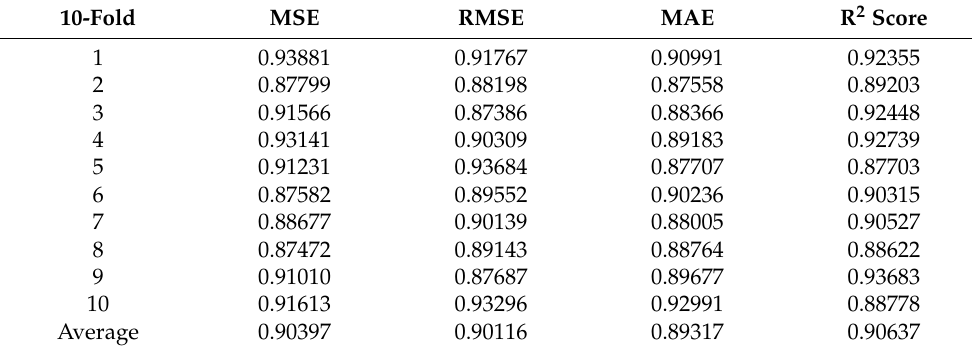
Table 10. Results for SVR.